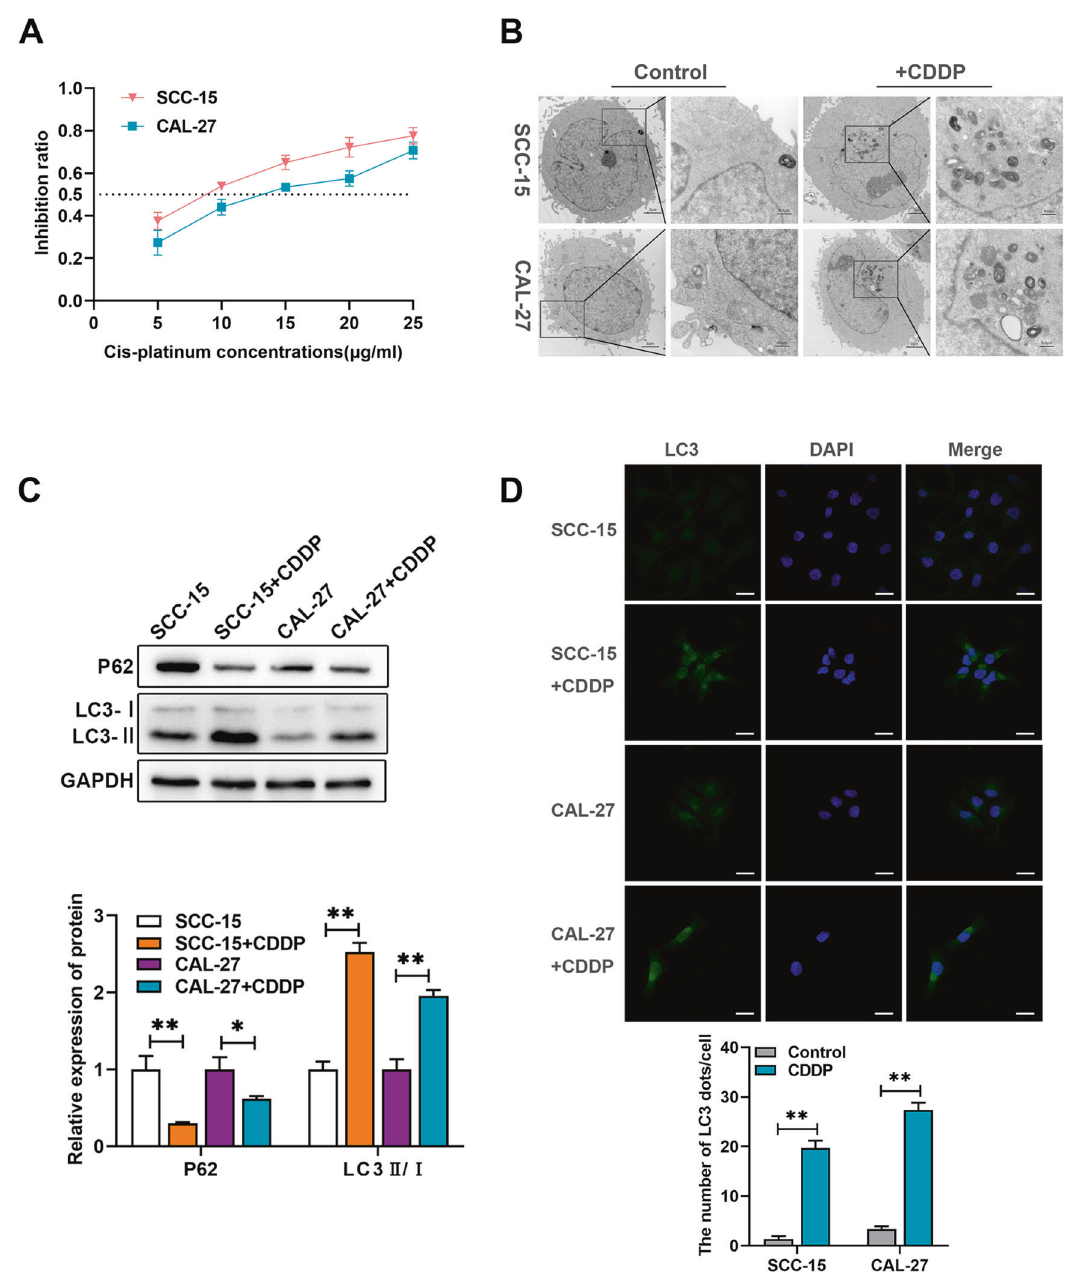
Fig. 1 Cisplatin (CDDP) triggered autophagy in SCC-15 and CAL-27 cells. A The cisplatin inhibition ratio was determined through CCK-8 proliferation assays. B Micrographs of SCC-15 and CAL-27 cells treated with and without cisplatin for 24 h were taken using a transmission electron microscope. C Western blotting results of the expression levels of LC3B and P62 of SCC-15 and CAL-27 cells treated with cisplatin for 24 h. D Immuno fl uorescence results of LC3B distribution in SCC-15 and CAL-27 cells treated with cisplatin for 24 h. * p < 0.05, ** p <